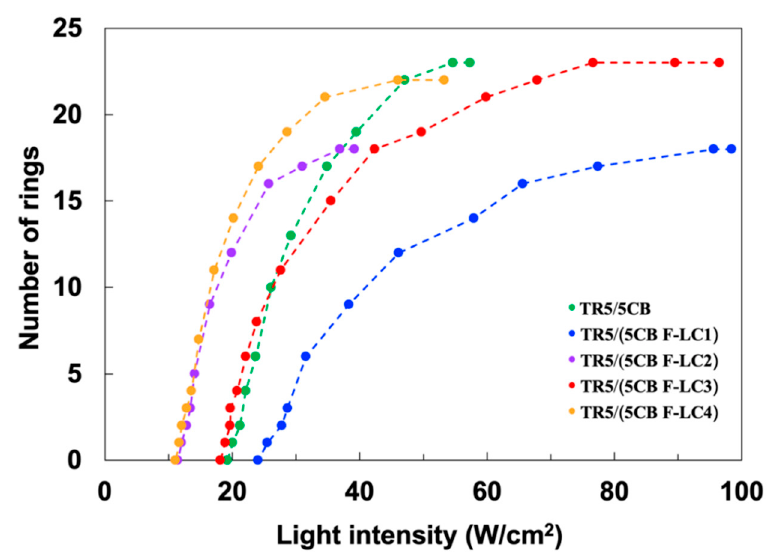
Figure 8. Number of diffraction rings of TR5/5CB, TR5/(5CB F-LC1), TR5/(5CB F-LC2), TR5/(5CB F-LC3), and TR5/(5CB F-LC4) as a function of light intensity.